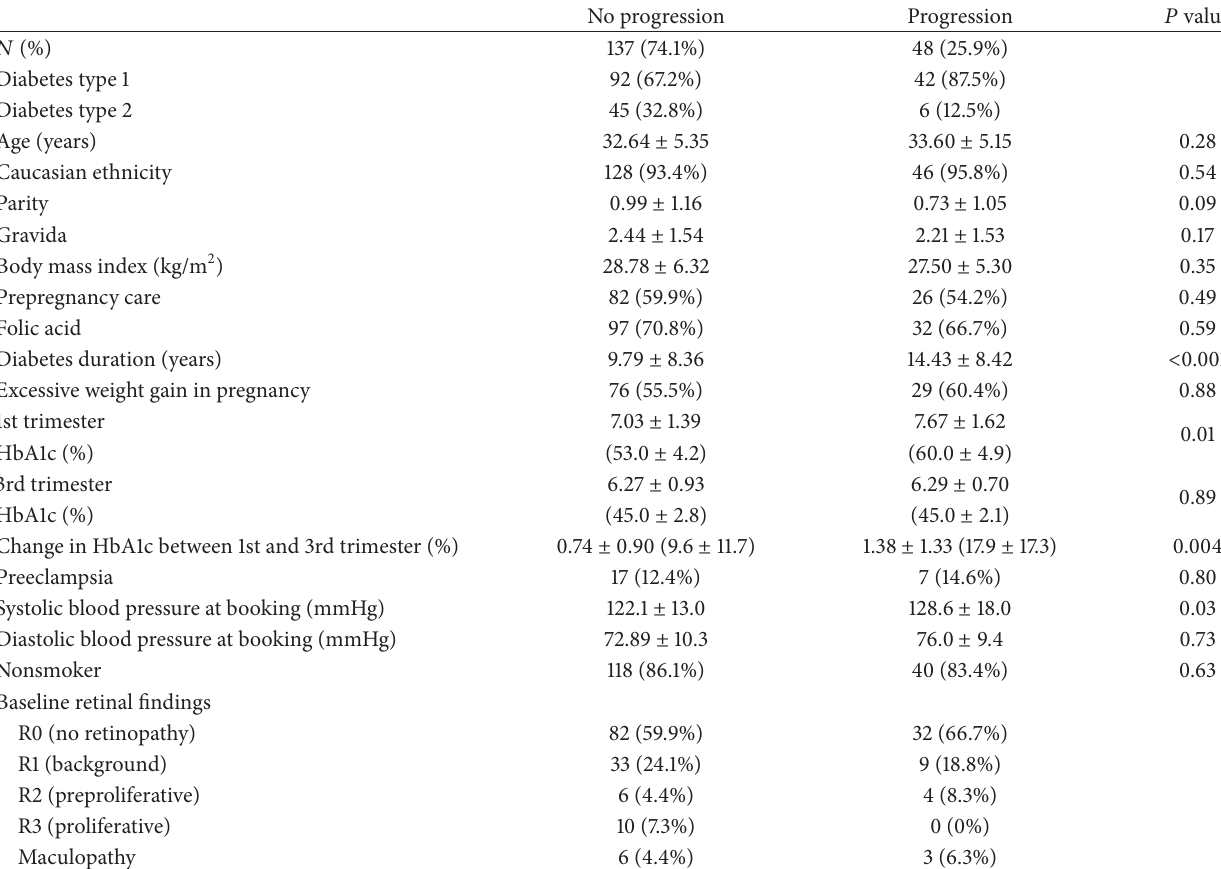
Data expressed as mean ± standard deviation (SD), number of patients, and % of group.